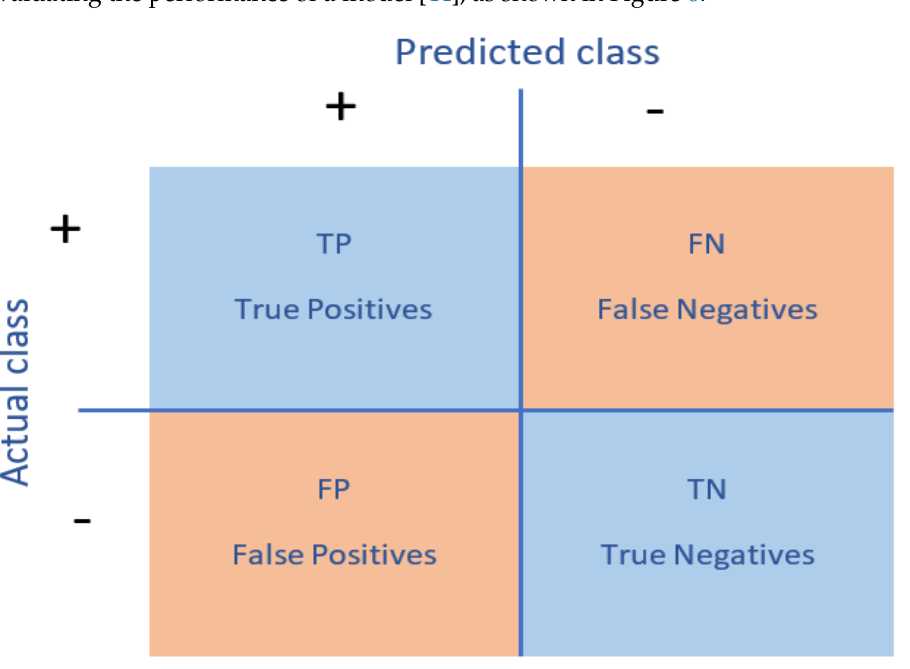
Table 3. Effectiveness main metrics.